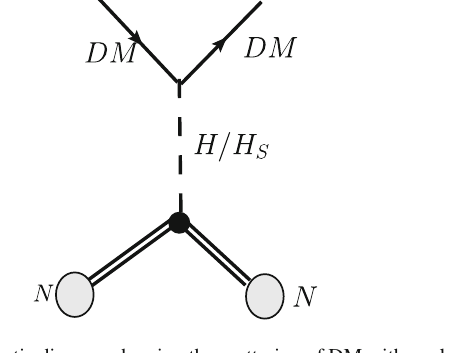
Fig. 2 Schematic diagram showing the scattering of DM with nucleus considered in the direct detection experiments